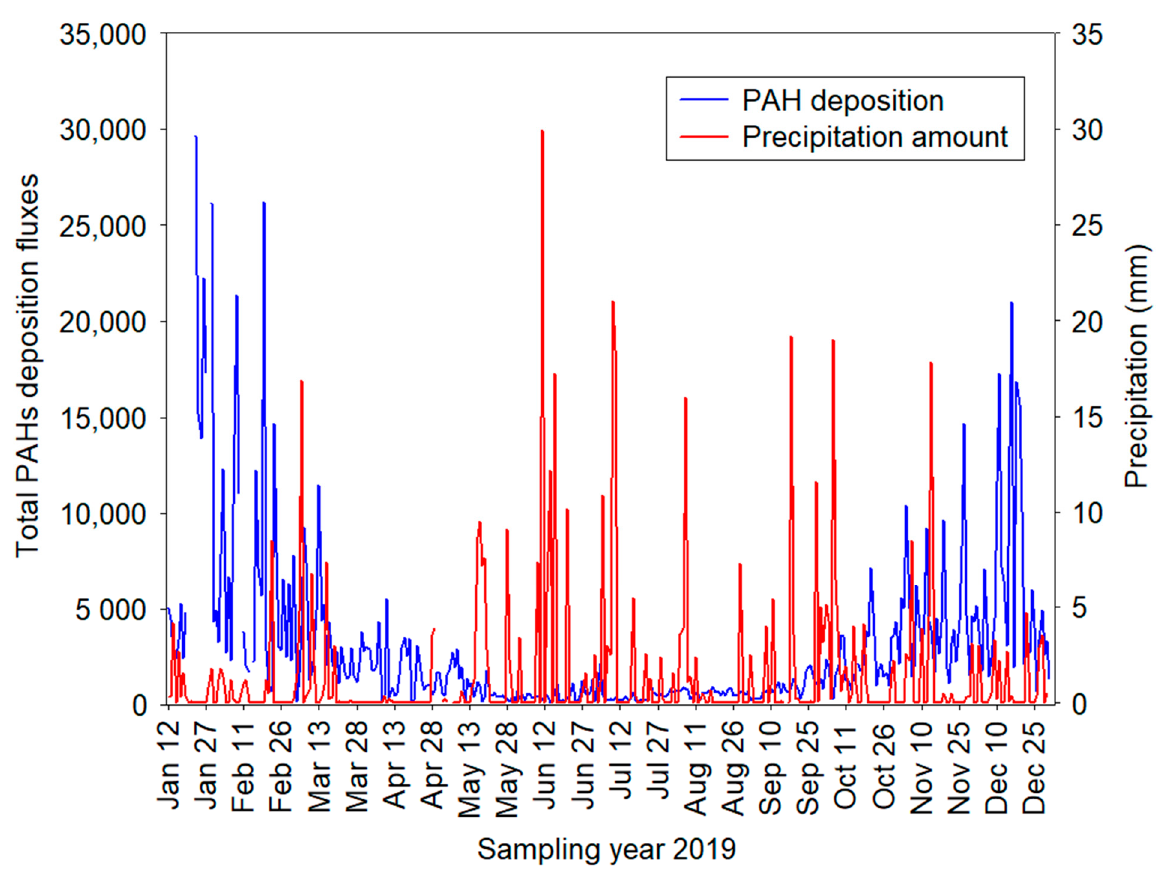
Figure 5. Daily profiles of Σ PAHs deposition fluxes (ng m − 2 day − 1 ) and precipitation (mm) during the study period 2019.